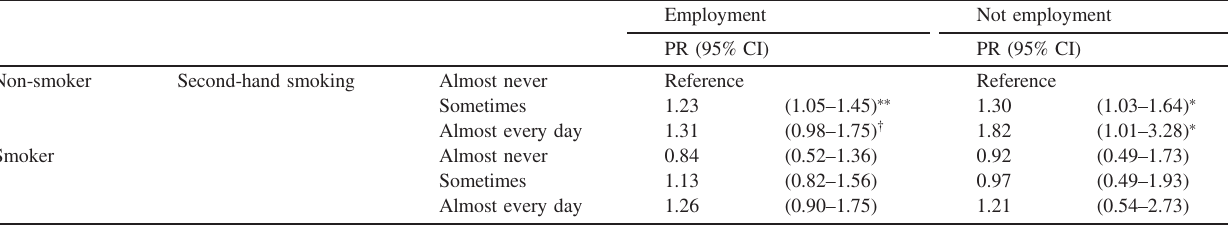
Table 3. PRs and 95% CIs for depressive symptoms, determined by multivariable Poisson regression analysis strati fi ed by employment